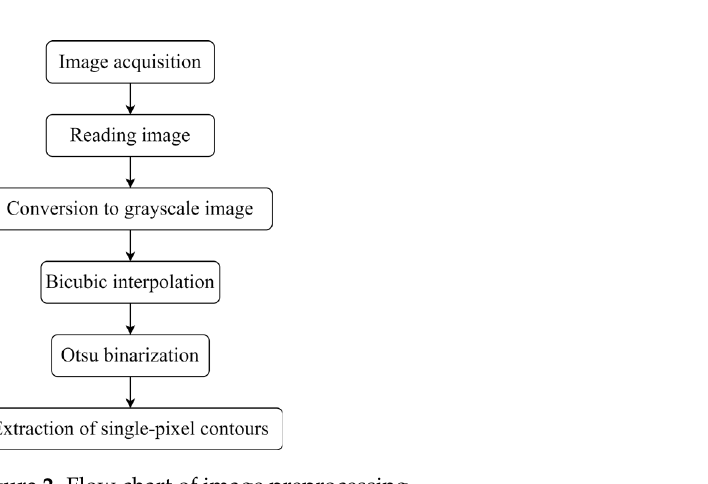
Figure 2. Flow chart of image preprocessing.